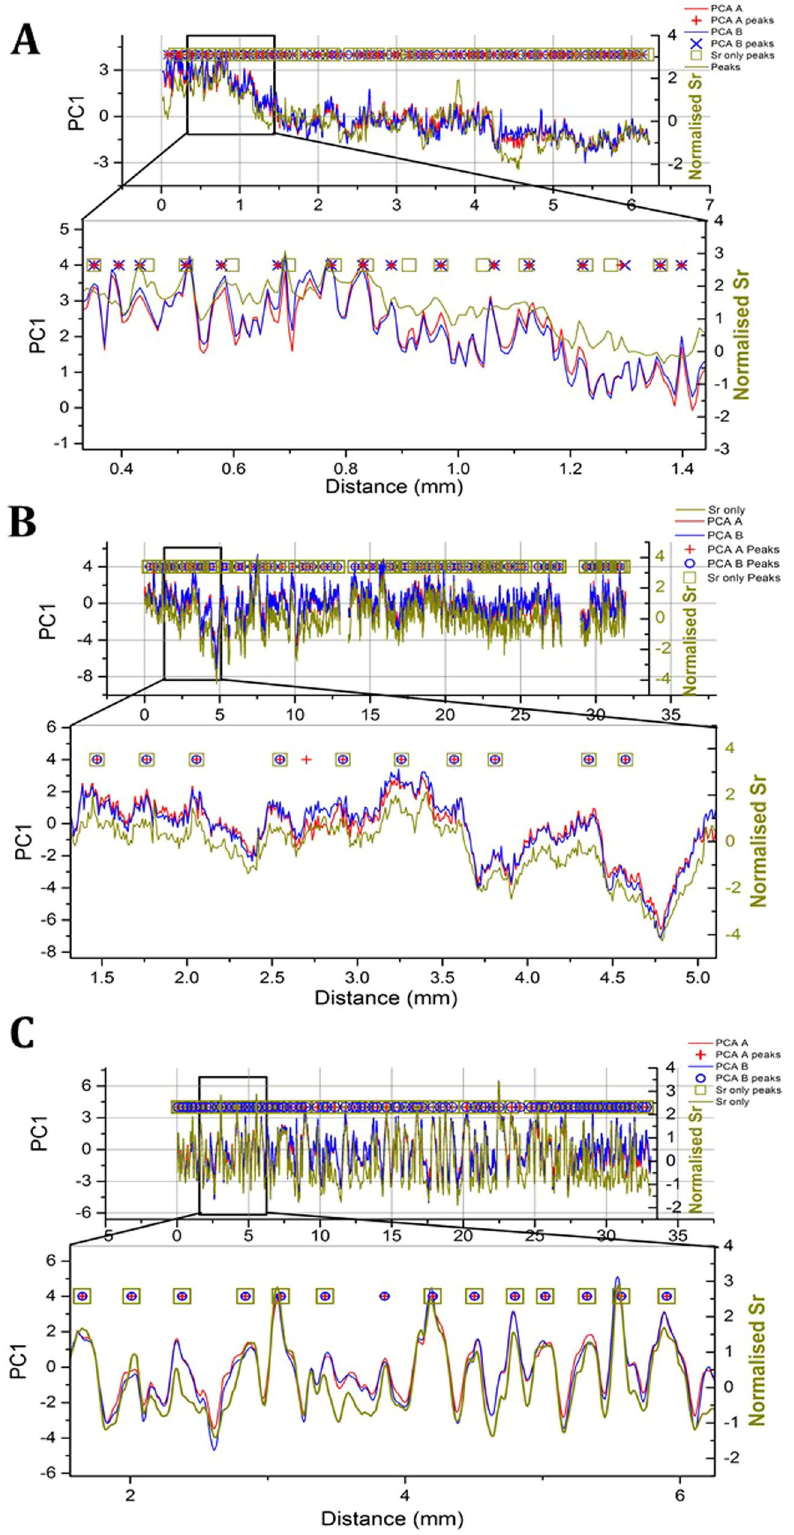
Figure 3. A comparison between peaks identified using three difference PCA experiments (PCA A, B and Sr only) for stalagmites YD-S2 ( A ), LAB-S1 ( B ), and MND-S1 ( C ). Only the PC1 time series output from one transect is shown for clarity. All methods locate similar, in phase peaks, although the output from Sr only tends to be smoother and have fewer